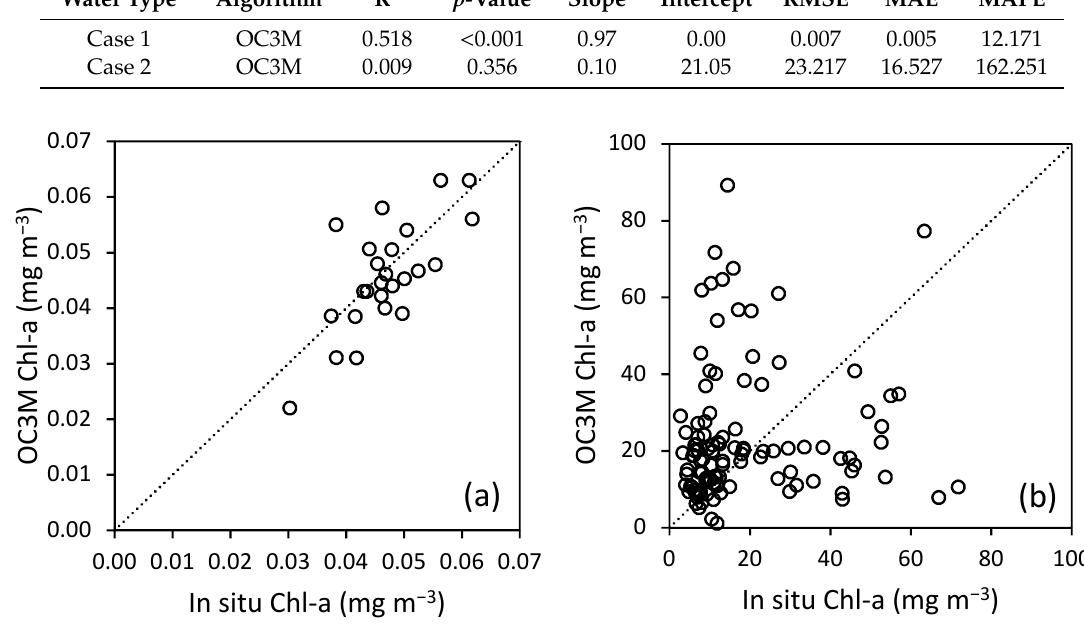
Figure 3. Scatter plots compare the OC3M derived Chl-a concentrations with in situ concentrations in ( a ) Sargasso Sea (case 1) and ( b ) Chesapeake Bay (case 2). The dotted lines represent 1:1 line.